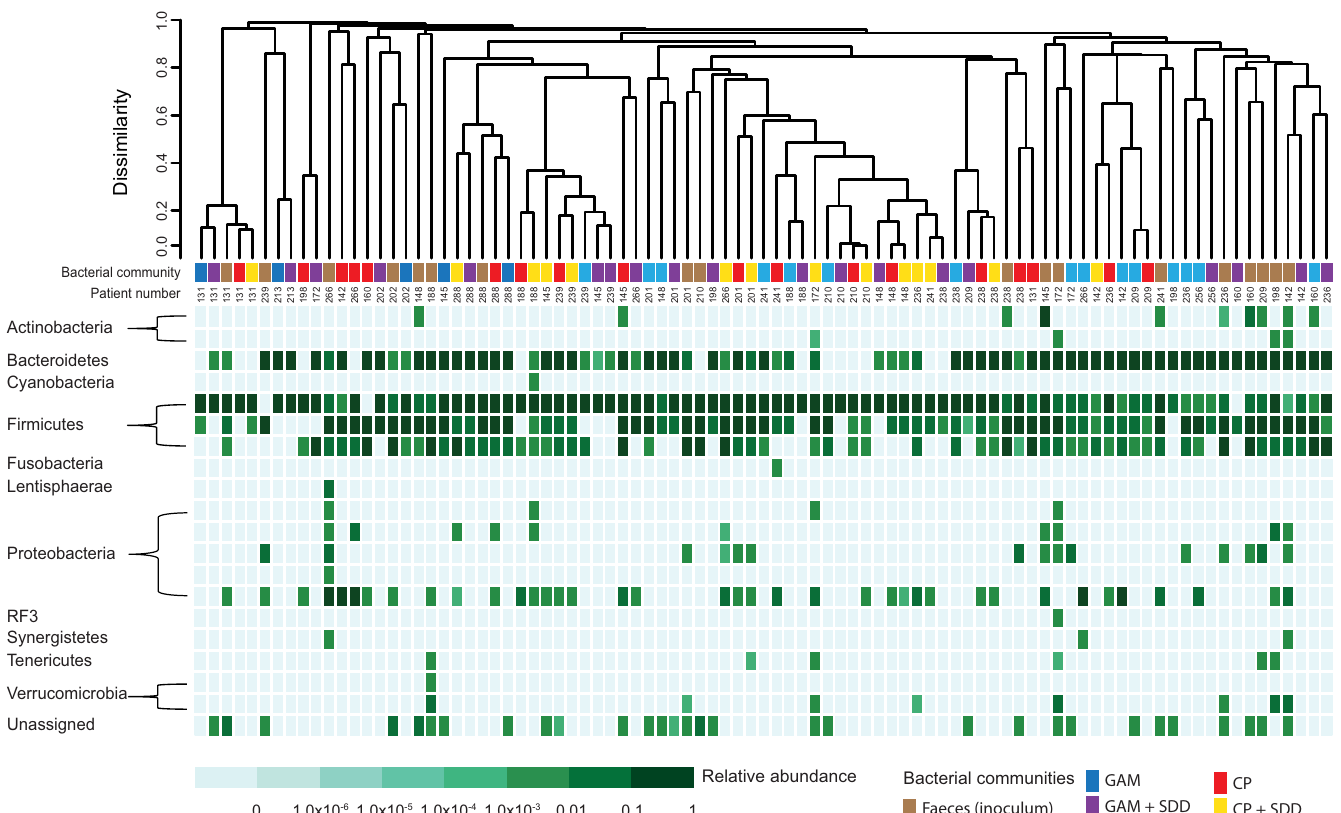
Fig 3. Hierarchical clustering using Bray-Curtis dissimilarity based on 16S rRNA gene amplicons generated from faecal samples of intensive care unit patients and corresponding biomass retrieved from PAO chips on GAM and CP agar. Growth on these media was further distinguished based on the addition of the SDD antibiotics. Hierarchical clustering was performed at the OTU-level. The heatmap corresponds to relative abundance values of class-level phylogenetic groups. For clarity, only communities derived from undiluted faecal samples, and only one of each biological (regarding growth communities) or technical (regarding faecal communities) replicate, was included in the dissimilarity